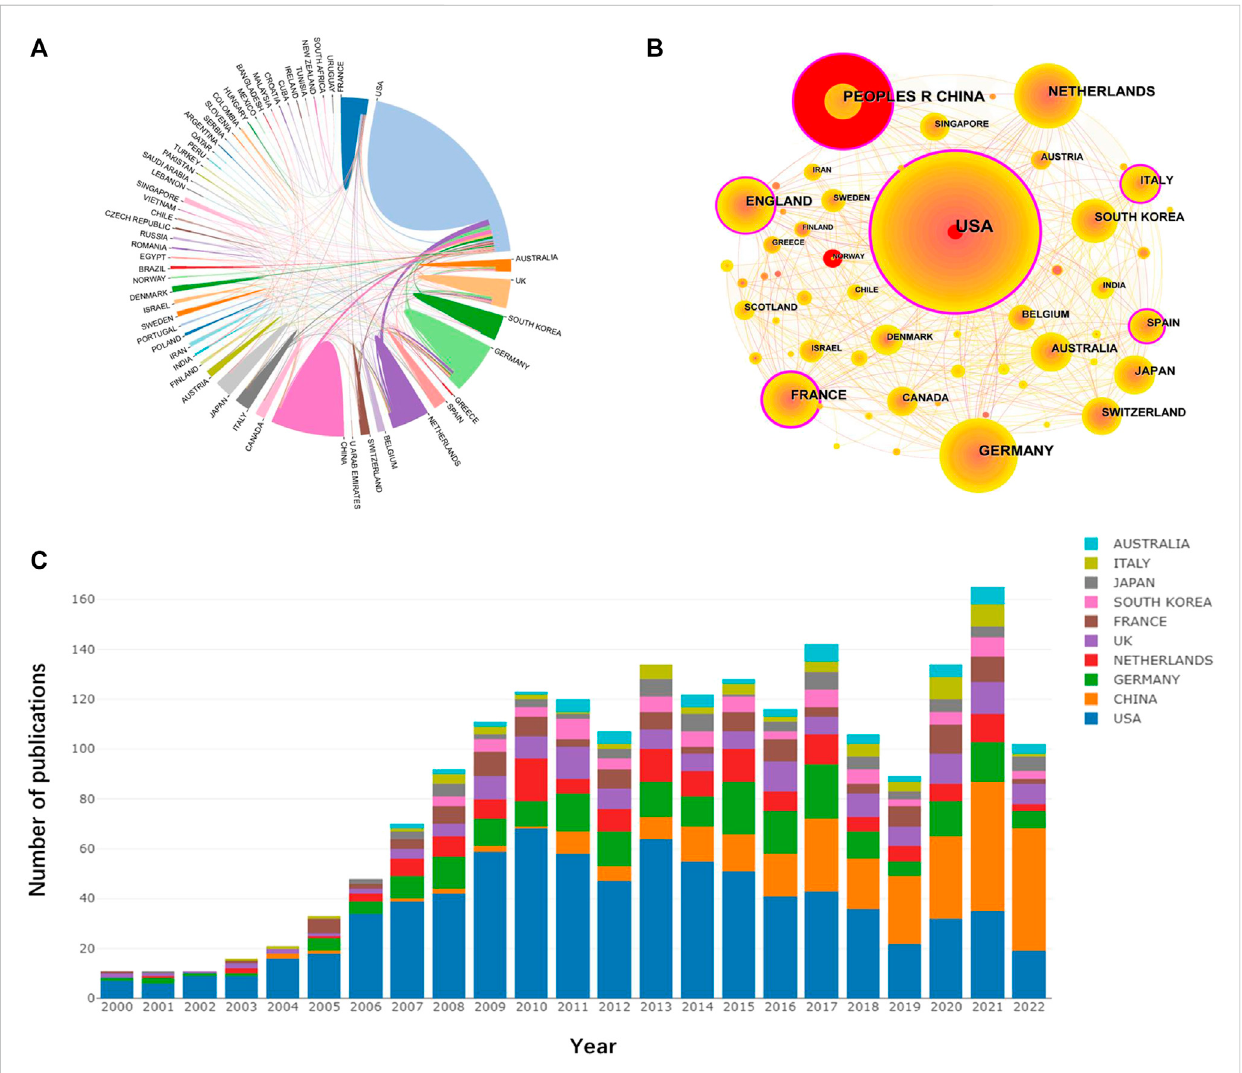
FIGURE 3 (A) The network of collaborating countries generated from an online bibliometric platform. The thickness of the line between countries re fl ects the strength of the cooperation relationship. (B) The network of collaborating countries/regions generated by Citespace. Highly central nodes are the outermost purple ring. Countries presenting the highest centrality are at the center of the network, which is considered the pivotal point in the research fi eld. The thickness of the outermost red ring indicates the burst level. (C) The trend of the annual publications in the top 10 countries/regions from 2000 to